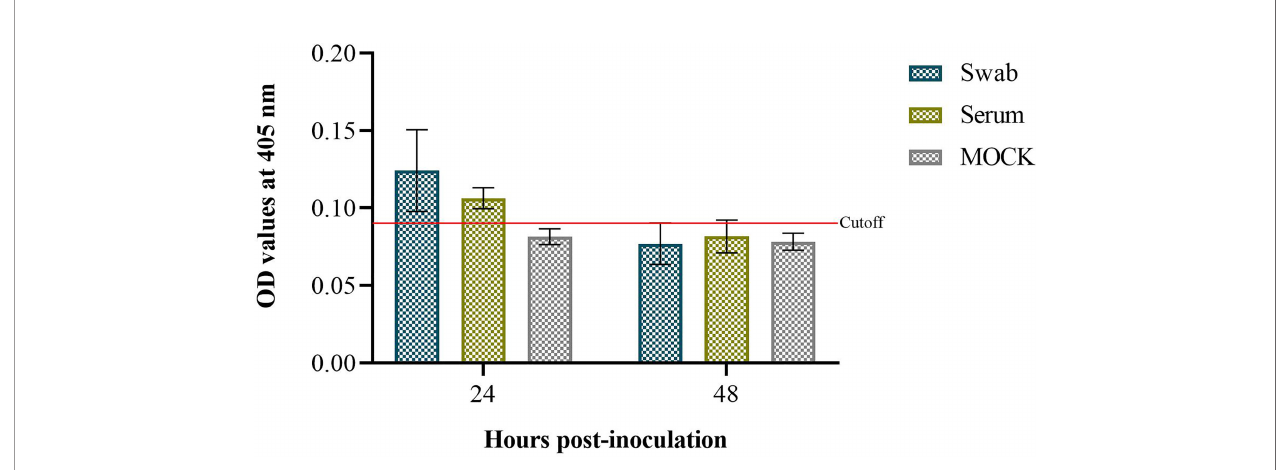
FIGURE 4 | Assessment of intranasally delivered IgY-R in hamster recovered from serum and nasal swabs. Cutoff value was set to 0.10 (CI = 95%). Mean ± SD (error bars) is presented (n = 4 per